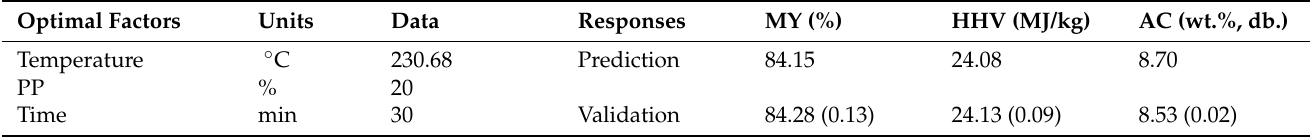
Table 4. Validation results for the optimized set of responses of